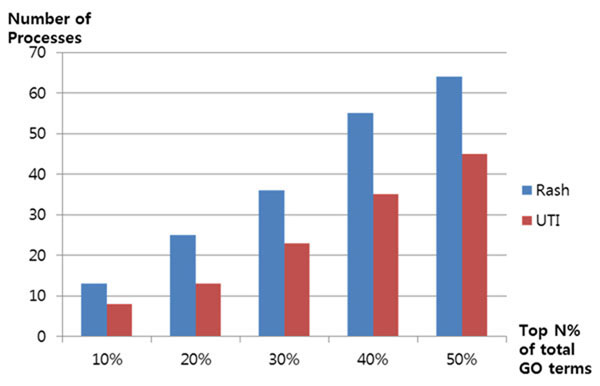
The number of processes matched with text-mining results for rash, and UTI. The x axis is the top n% of co-occurred GO terms with biological processes (total 2,209). The y axis is the number of processes with scores greater than the top n% (x axis) threshold of the total process scores